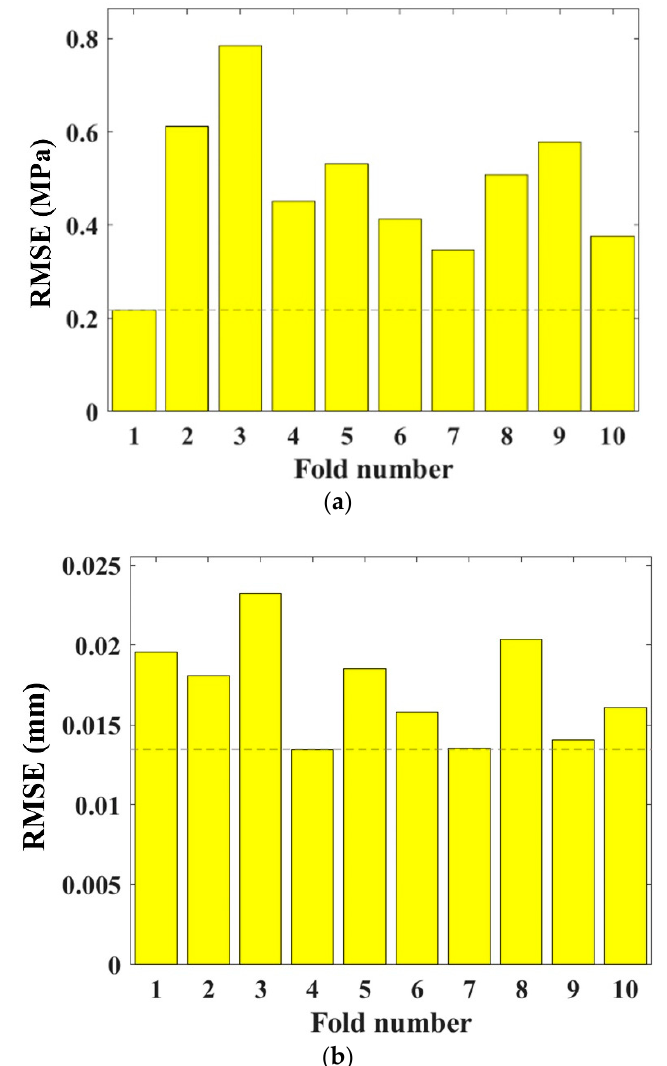
Figure 11. RSME values from 10 validation sets for ( a ) FS and ( b ) ASR modelling.